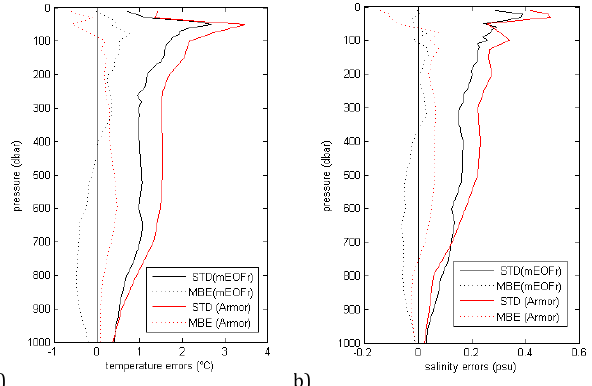
Fig. 6. Weekly comparison of temperature and salinity profiles from mEOF-r and and synthetic ARMOR3D using Odyssea SST (a) and MESCLA SSS (b) .